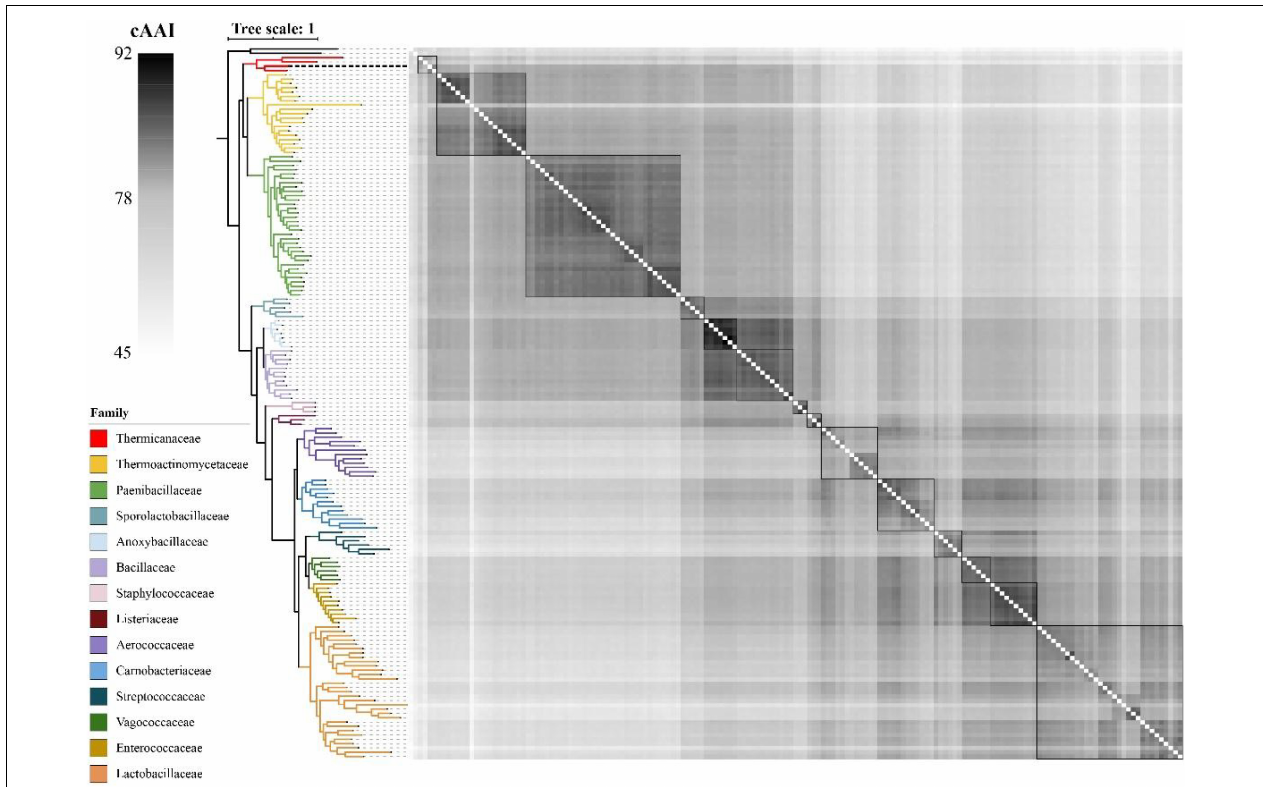
FIGURE 5 | Heatmap depicting the cAAI values of the 165 pairwise comparisons in class Bacilli. The left phylogenetic tree shows the phylogenetic relationships of different families, and the right heatmap shows the cross matrix of the core-genes average amino acid identity values between each genus. The order of each branch is identical to that of Figure 4 . The black dash line shows (cid:77) strain